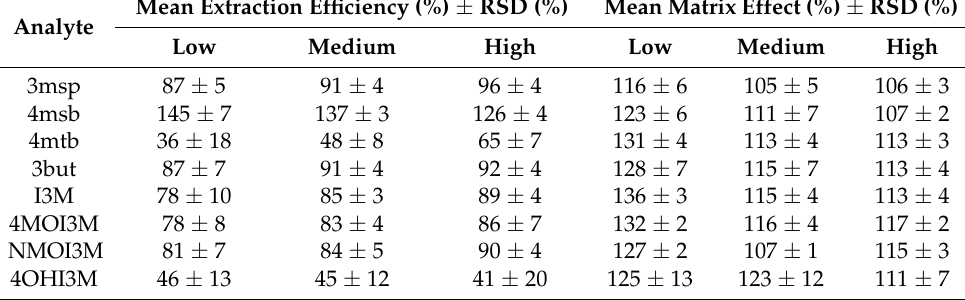
Table 1. Extraction efficiency and matrix effect of each analyte at three concentration levels tested ( n = 6). Glucosinolate mixed standard solutions were spiked with the purpose of obtaining the three concentration levels of a low (3 ng/mL), medium (30 ng/mL) and high (90 ng/mL). Full names and abbreviations: glucoraphanin (4msb), glucoerucin (4mtb), glucoiberin (3msp), gluconapin (3but), glucobrassicin (I3M), 4-methoxyglucobrassicin (4MOI3M), neoglucobrassicin (NMOI3M) and 4-hydroxyglucobrassicin